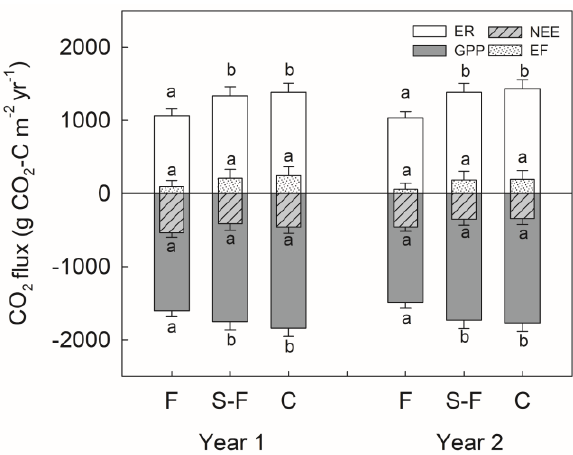
Figure 10. Annual budgets of ecosystem respiration (ER), gross primary production (GPP), net ecosystem exchange (NEE) and CO emission 2 factor (EF; calculated as the sum of NEE and carbon exported in harvested biomass). Data are shown for flooded (F), semi-flooded (S-F) and control (C) plots. Error bars represent the upper 95 % confidence interval ( n = 8 for F plots, n = 4 for S-F and C plots). Treatments marked with different letters denotes significant differences within each year ( P <